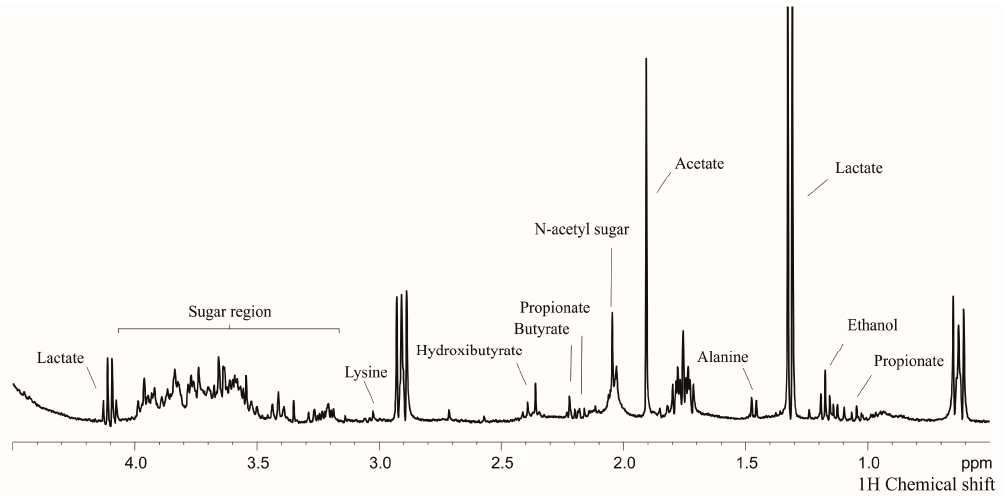
Figure 1. Representative 1 H-NMR spectrum of the saliva of young children (20 months old): the 0.5 to 4.5 ppm region.